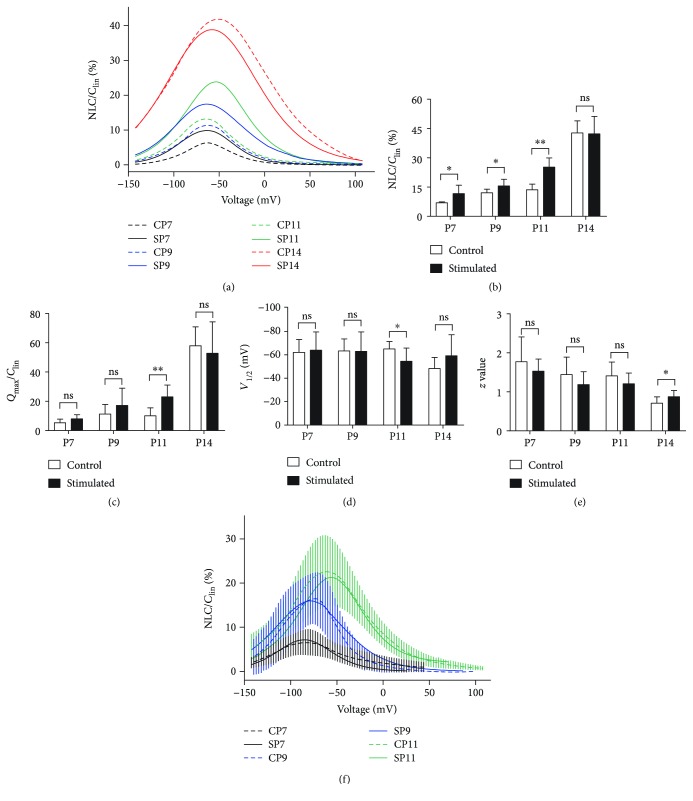
Low-frequency sound environment stimulation enhances the NLC response of OHCs from the apical turns of the cochleae. (a) Means of NLC from low-frequency noise-stimulated (SP, solid lines) and control (CP, dashed lines) OHCs in apical cochlea at P7 (SP7, n = 8; CP7, n = 5), P9 (SP9, n = 9; CP9, n = 8), P11 (SP11, n = 12; CP11, n = 9), and P14 (SP14, n = 13; CP14, n = 10). The mean capacitance-voltage responses were fitted with the Boltzmann function. (b–e) Four parameters obtained from curve fitting using the Boltzmann function. All data points represent the mean ± standard deviation. ∗p < 0.05; ∗∗ p < 0.01; NLC: nonlinear capacitance; ns: no significance; OHC: outer hair cell; P: postnatal day. (f) Means of NLC from low-frequency noise-stimulated (SP, solid lines) and control (CP, dashed lines) OHCs in basal cochlea at P7 (SP7, N = 5; CP7, N = 12), P9 (SP9, N = 4; CP9, N = 9), and P11 (SP11, N = 4; CP11, N = 8). The mean capacitance-voltage responses were fitted with the Boltzmann function. The SDs of mean NLCs are indicated by the vertical bars for the controls. No significant difference was found between the two groups (p > 0.05, repeated ANOVA).